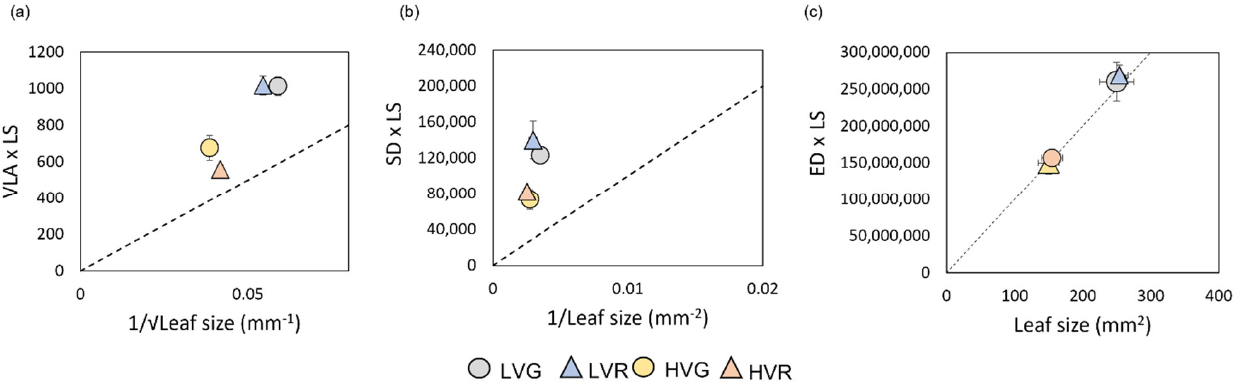
Figure 2. ( a ) Vein density per leaf size (VLA × LS) and 1√leaf size, ( b ) stomatal density per leaf size (SD × LS) and 1/leaf size and ( c ) total epidermal cell number per leaf size (ED × LS) and leaf size of grey (circles) and red (triangles) Salanova lettuces grown under low and high VPDs. Mean values ± standard errors are shown. Broken line represents the proportional relationships.